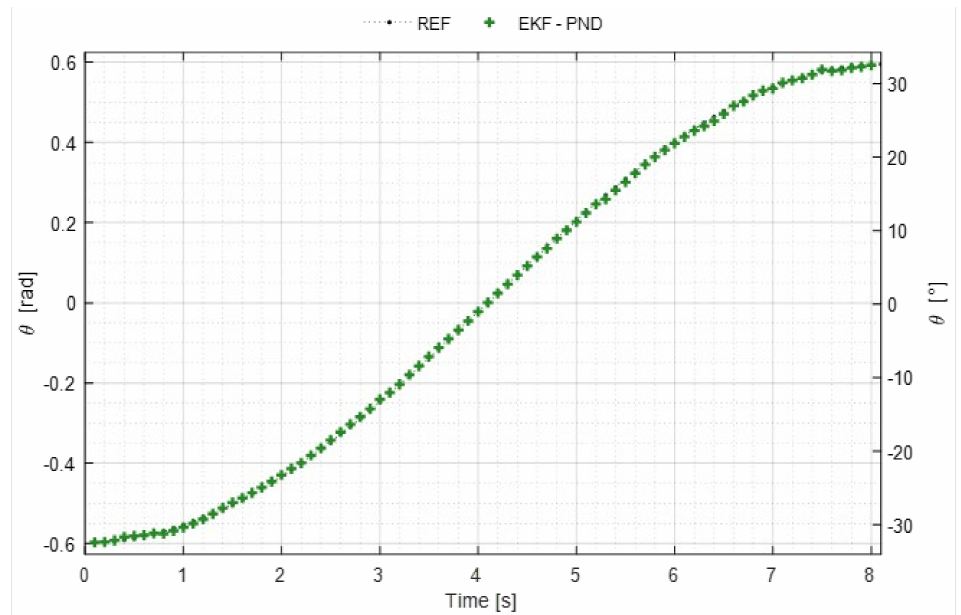
Figure 13. Angle between the horizontal projection of the antenna handle and the central axis of the scanning section estimated with EKF-PND.